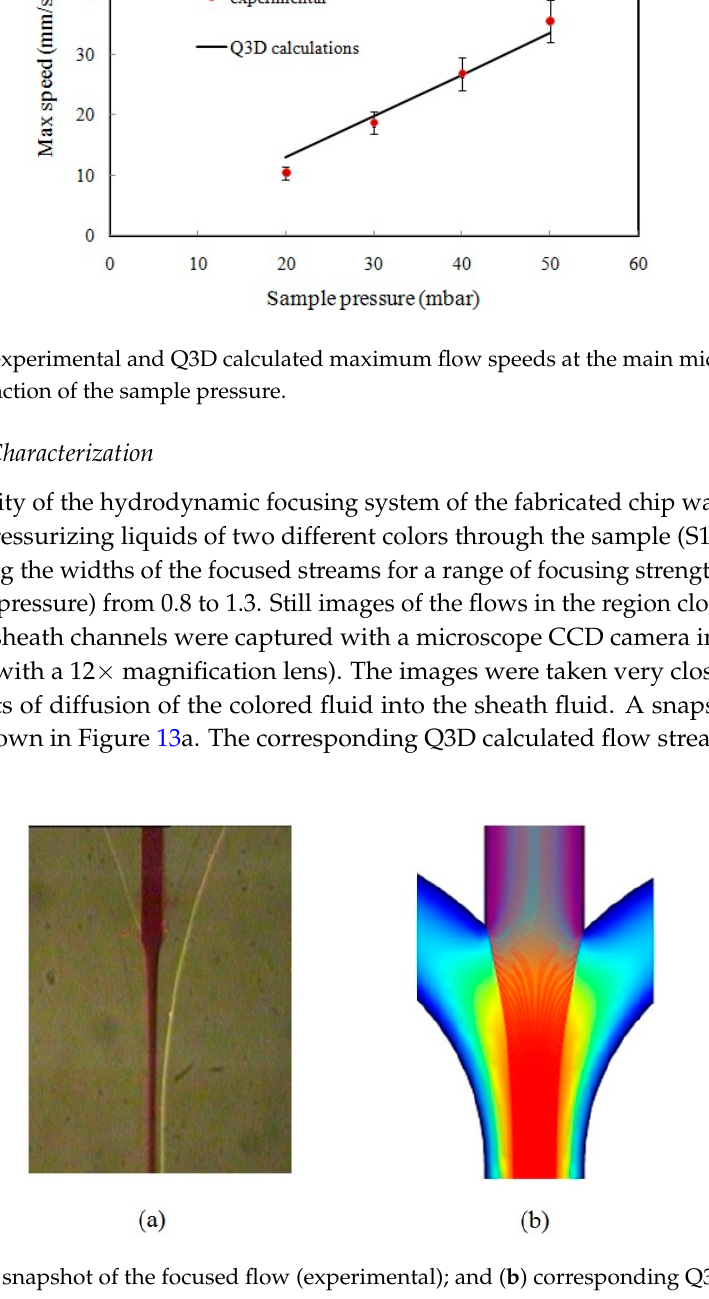
Figure 13. ( a ) A snapshot of the focused flow (experimental); and ( b ) corresponding Q3D calculated flow streams.